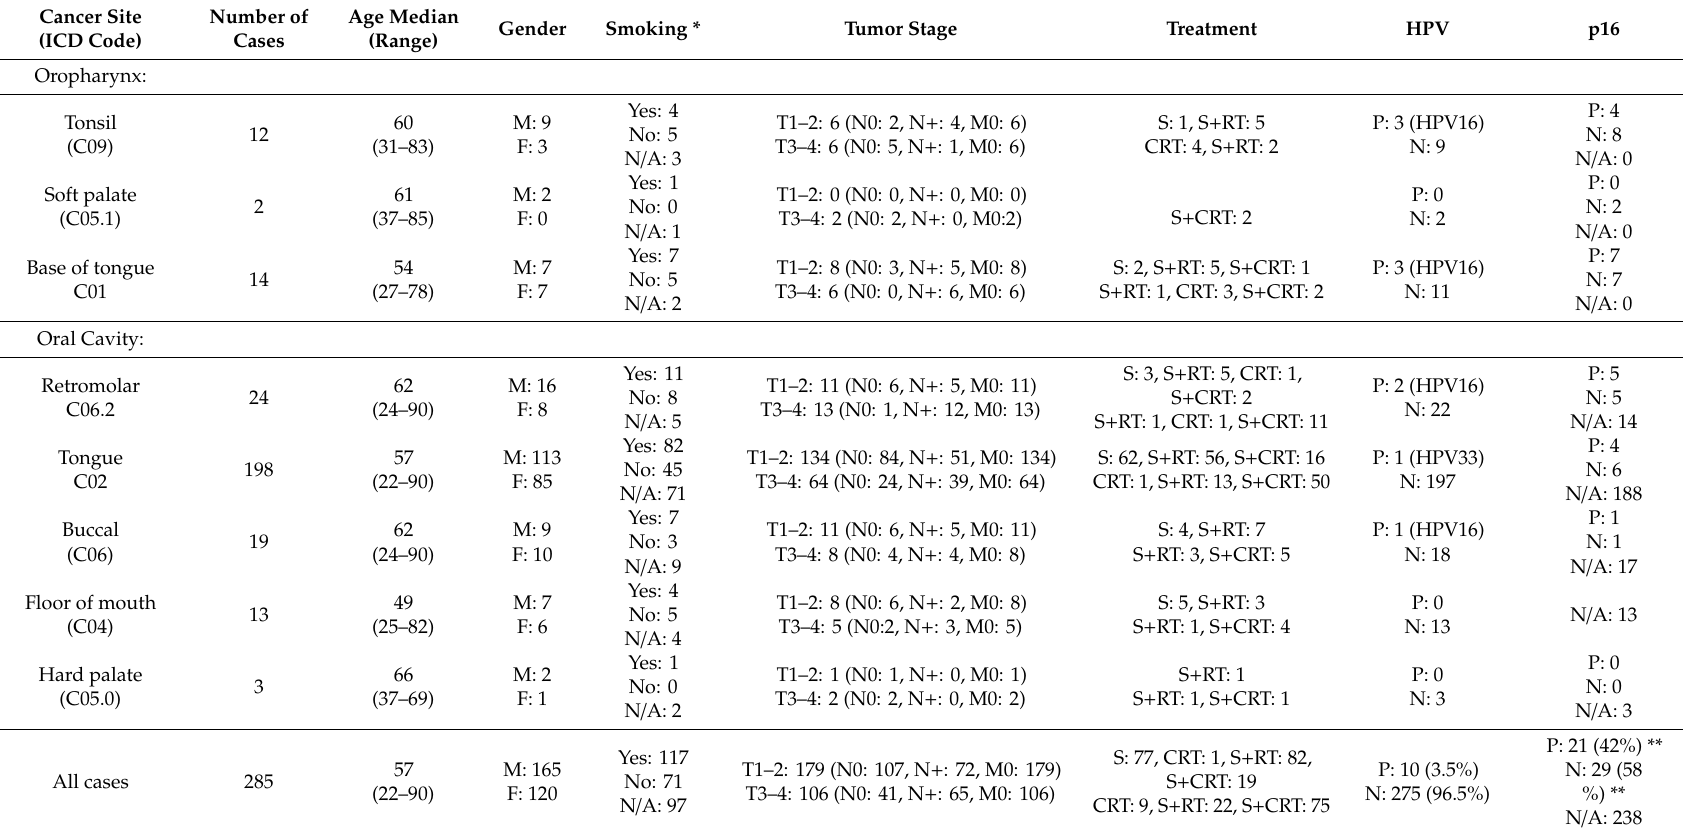
Table 1. Descriptive statistics of 285 head and neck squamous cell carcinoma patients with results of HPV and p16 INK4a tests. Cancer Site Number of Age Median Gender Smoking * Tumor Stage (ICD Code) Cases (Range)